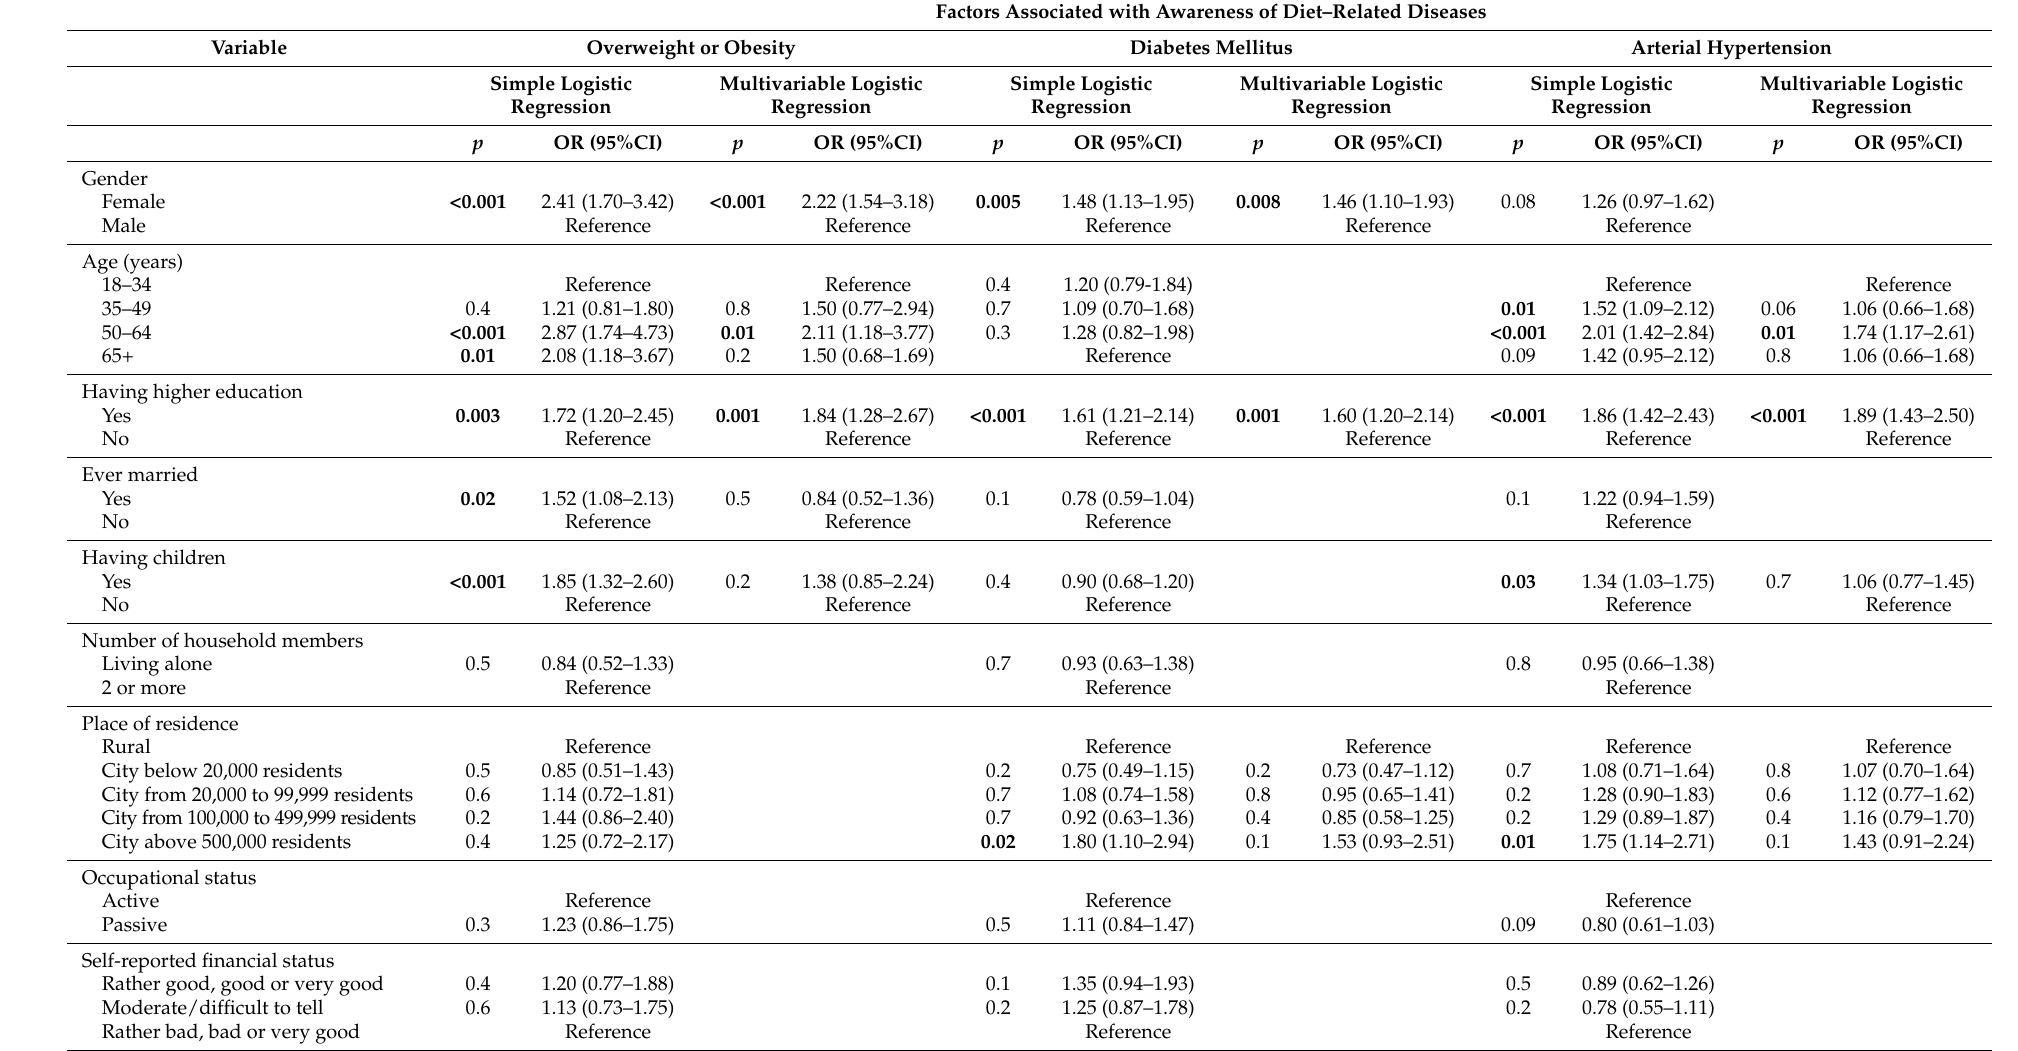
Table 5. Factors associated with awareness of diet-related diseases ( n =